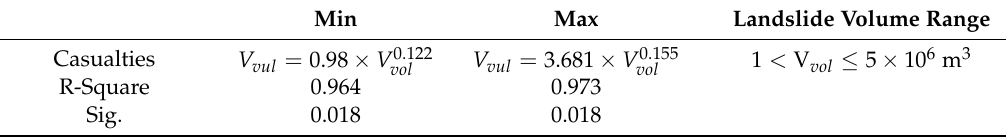
Table 4. Maximum/Minimum threshold value curve of casualties caused by